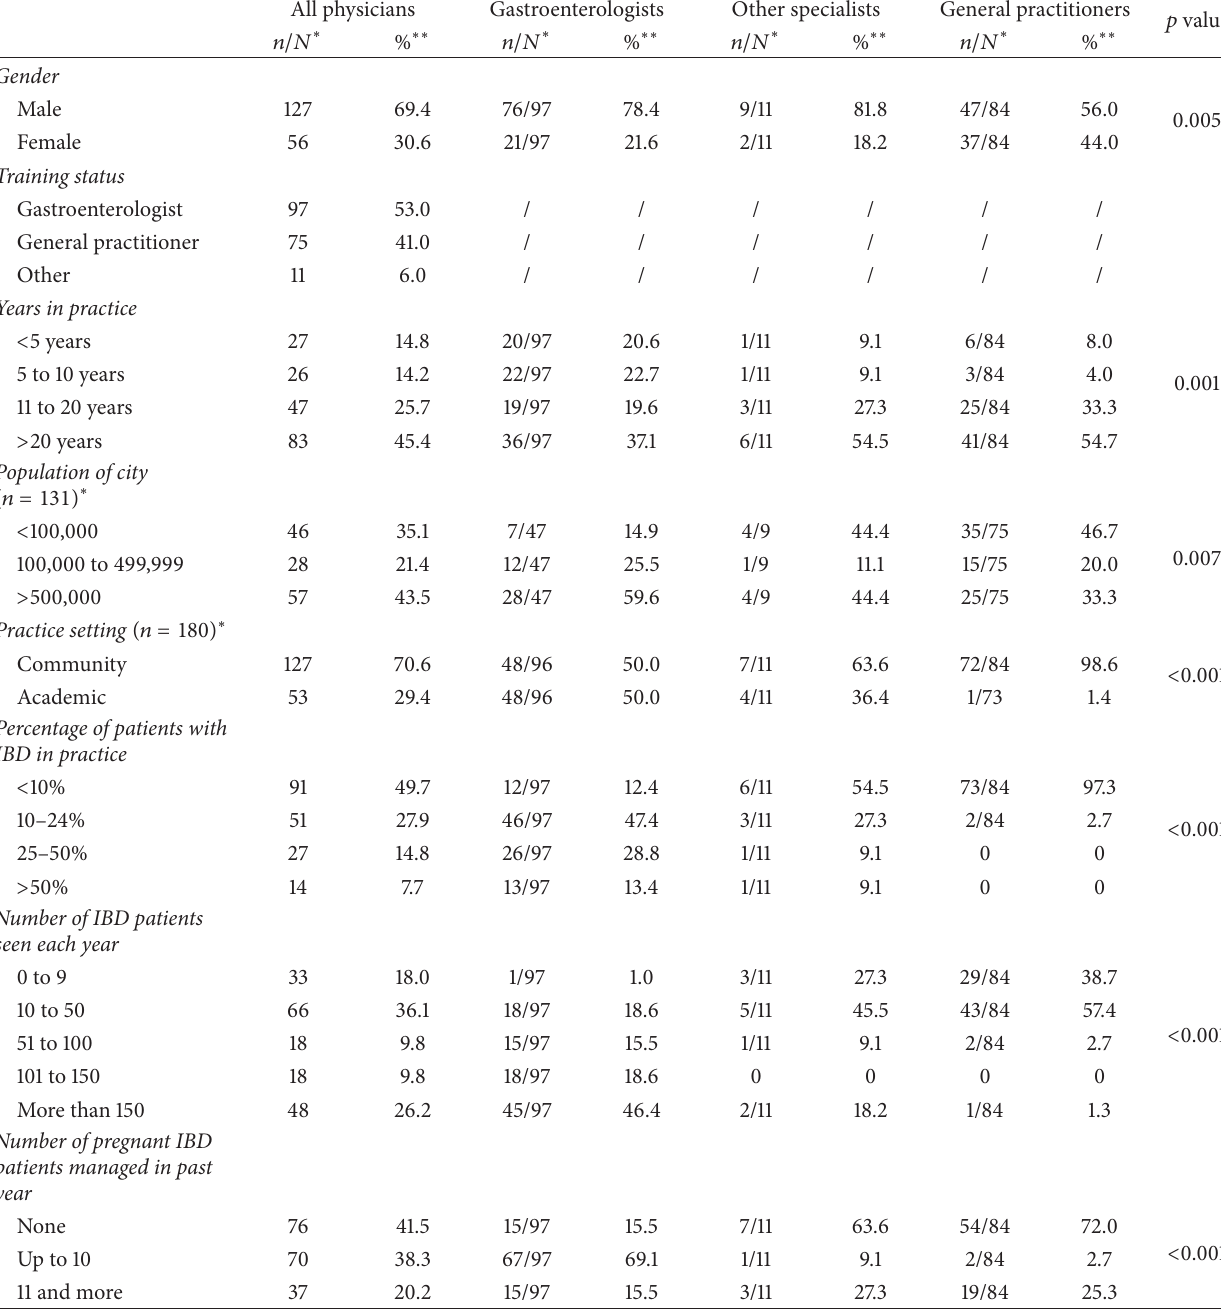
Table 1: Characteristics of practicing Canadian physicians surveyed regarding the management of IBD during pregnancy and breastfeeding. All